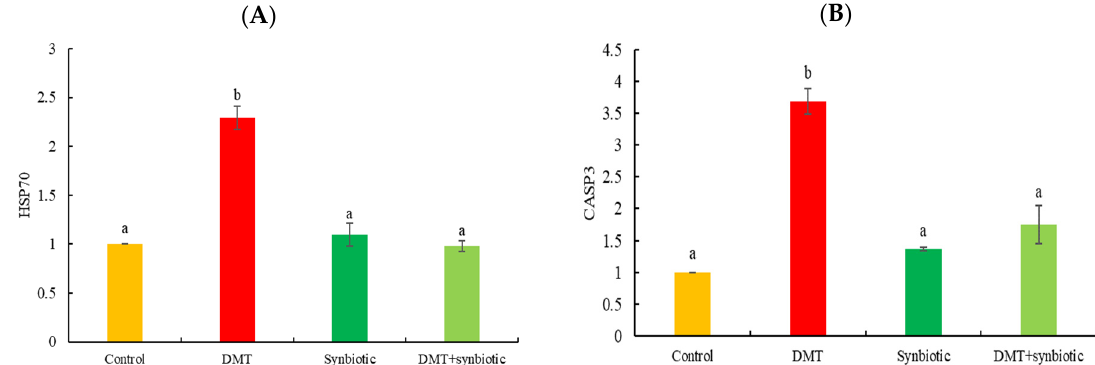
Figure 7. Transcription of ( A ) heat shock protein 70 (HSP70) and ( B ) caspase 3 (CASP3) in Nile tilapia treated with deltamethrin (DMT) with synbiotic feeding. Bars represent mean ± SD (n = 3), and different letters show significant differences ( p < 0.05).